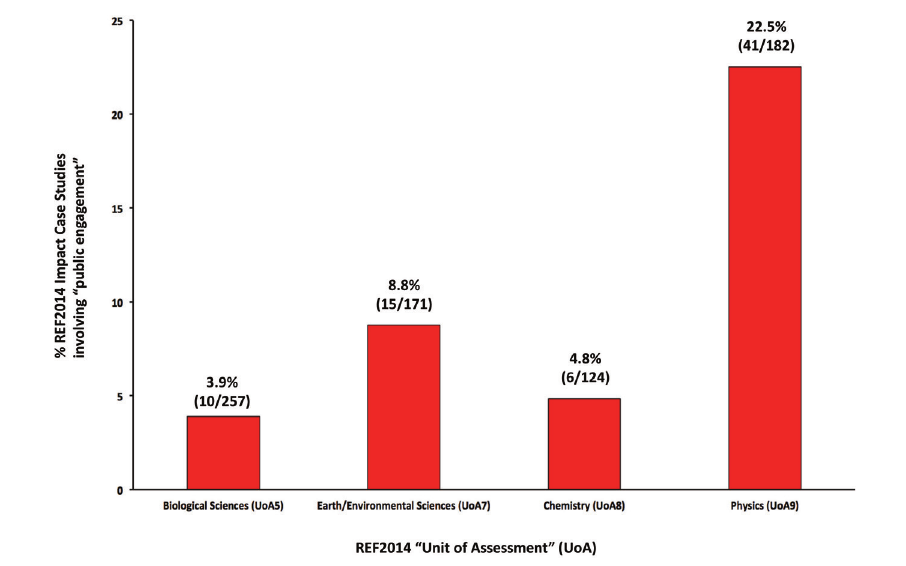
Figure 1: Proportions of REF2014 Impact Case Studies featuring public engagement submitted to individual Units of Assessment for sciences (data compiled by the author from published REF Impact Case Studies, using criteria similar to Duncan and Manners (2017) to define public